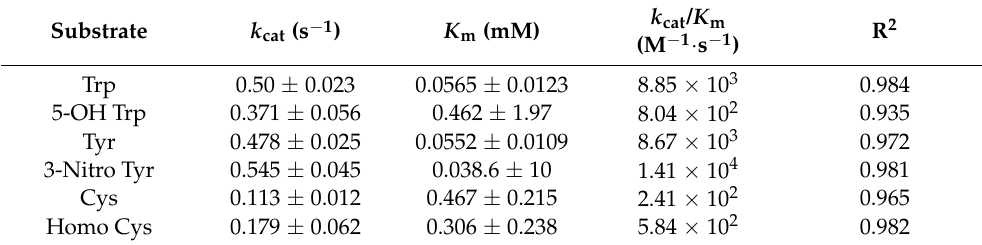
Table 2. Steady-state kinetic parameters for the reaction of P. luteoviolacea CPMOR-1 LAAO with L-amino acid substrates. Each amino acid was assayed as described in the Section 4 at pH 7, 25 ◦ C, and fit with Equation (1). Values are the average of at least three replicates. The R 2 values for the fits of the data for each amino acid substrate are given.